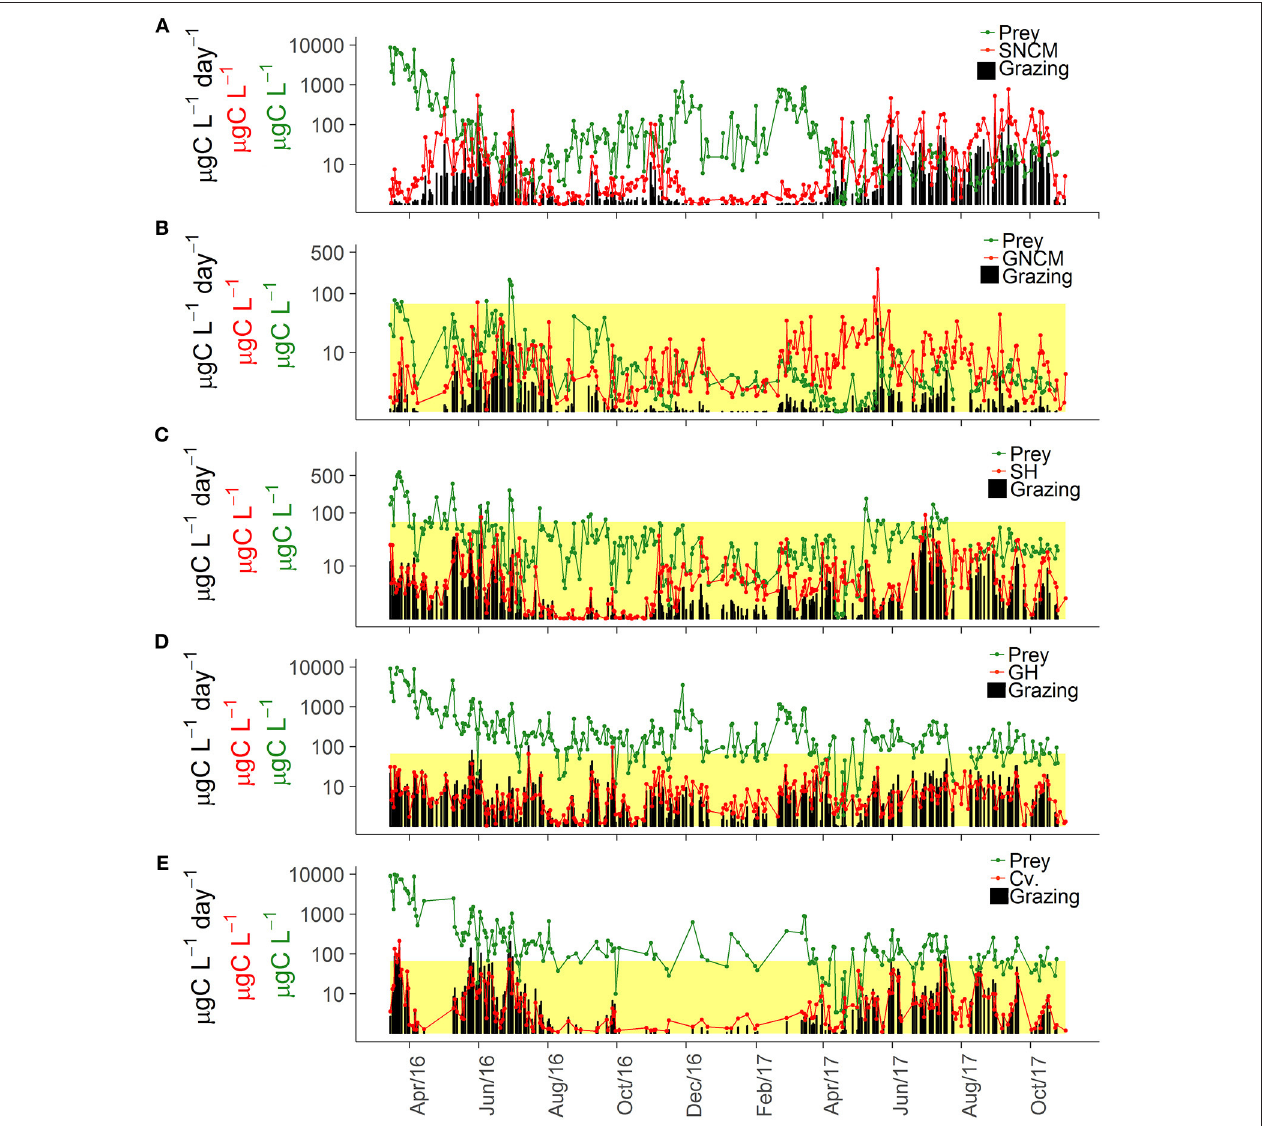
FIGURE 5 | Temporal dynamics of assigned phytoplankton prey, ciliate biomass, and potential grazing rates for the different trophic strategies: SNCM, Specialist Non Constitutive Mixotroph (A) , GNCM, Generalist Non Constitutive Mixotroph (B) , SH, Selective Herbivore (C) , GH, Generic Herbivore (D) , and Cv, Carnivore (E) . The upper limits of the yellow colored area indicate the half-saturation constant for food density (Km), thus when prey concentrations are smaller than Km (within the yellow area) it indicates potential food limitation. As SNCM potential grazing (A) was estimated in a distinct way, the Km criteria was not used for this trophic strategy. For further details on Km definition and calculation, see “Potential Grazing” in the section Materials and